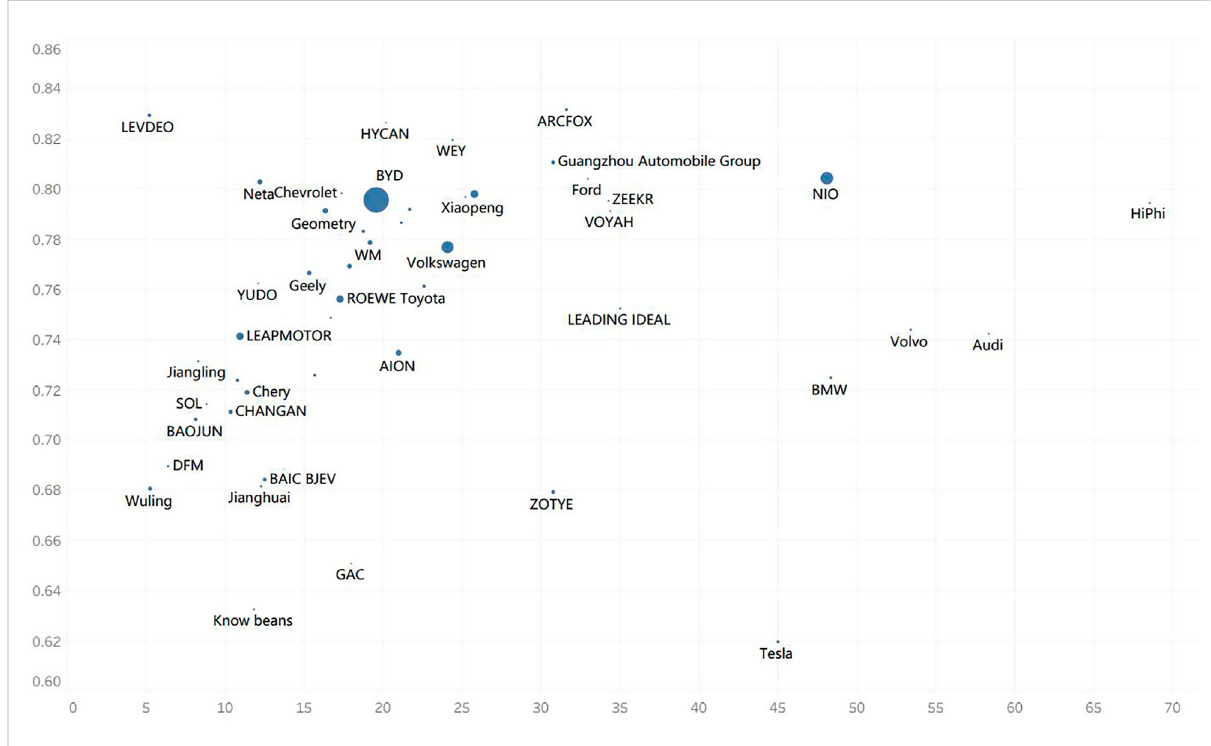
FIGURE 13 Distribution map of the average sentiment score of different brands of